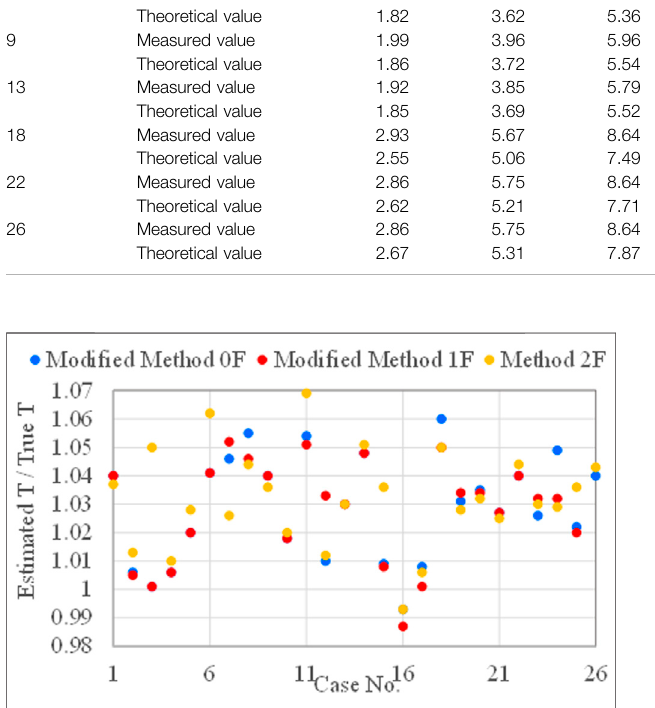
FIGURE 8 | Tension estimation results after fi xing modal